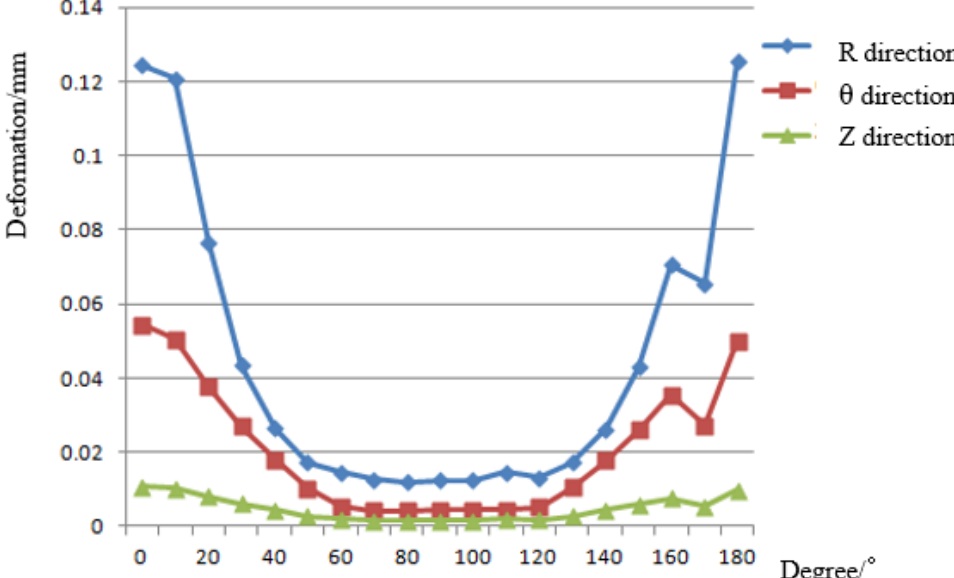
Figure 3. Deformation in three directions at different machining positions.